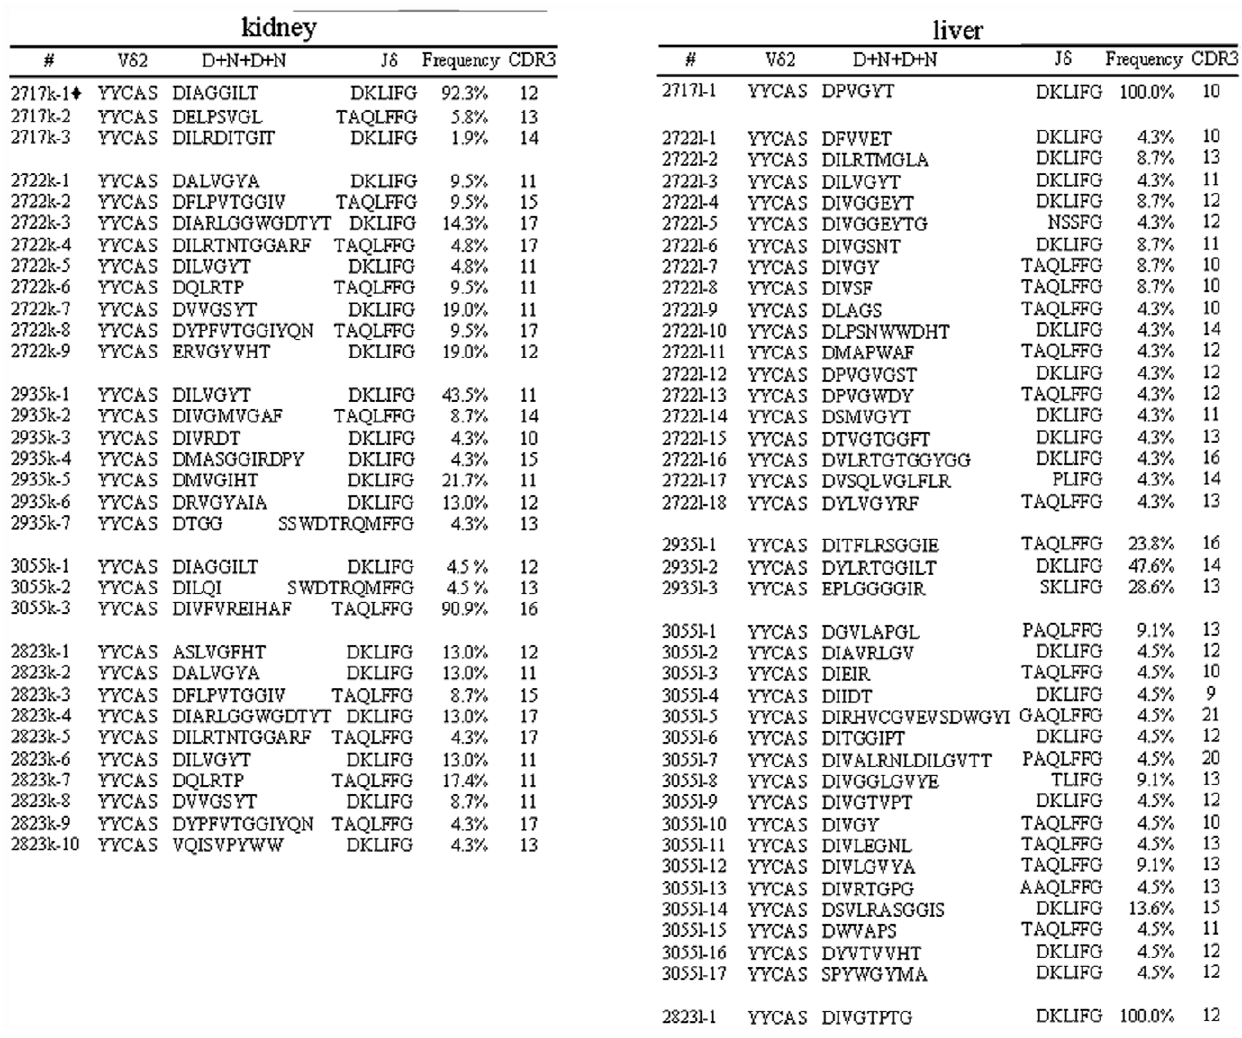
Figure 3. Some V d 2 T cell clones of V c 2V d 2 T-cell subpopulation appeared to be more predominant than others in lately Mtb- infected liver or kidney. The localization of V c 2V d 2 T cells in interstitial tissues of kidney or liver were shown in the previous publication [18]. Expansion of V c 2V d 2 T cells in CD3 + T cells isolated from the kidney or liver tissues were described in the text. Note that three macaques(2717, 3055, 2935) exhibited dominance of a single clone or oligo-clones bearing a same length of CDR3 in TCR cDNA derived from kidney lymphocytes in which expansion of V c 2V d 2 T cells was detected. In cDNA derived from liver lymphocytes, a dominance of a single TCR clone or clones with a restricted CDR3 length was also noted in three macaques (2717, 2823, 2935). Clones marked by ‘ ¤ ’were present in the blood,lung and